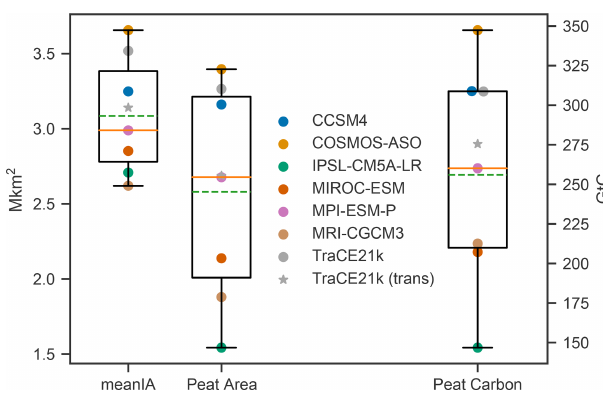
Figure 3. Spread of the global annual mean inundated area (meanIA), peatland area, and peatland carbon during the LGM (21kyrBP) in time slices forced with climate anomalies from seven different climate models (see Sect. 2.2). The box, the solid line, and the dashed line indicate the interquartile range, the median, and the mean from the seven simulations, respectively. The star indicates the values of the transient simulation for the same time period using climate anomalies from TraCE21k.